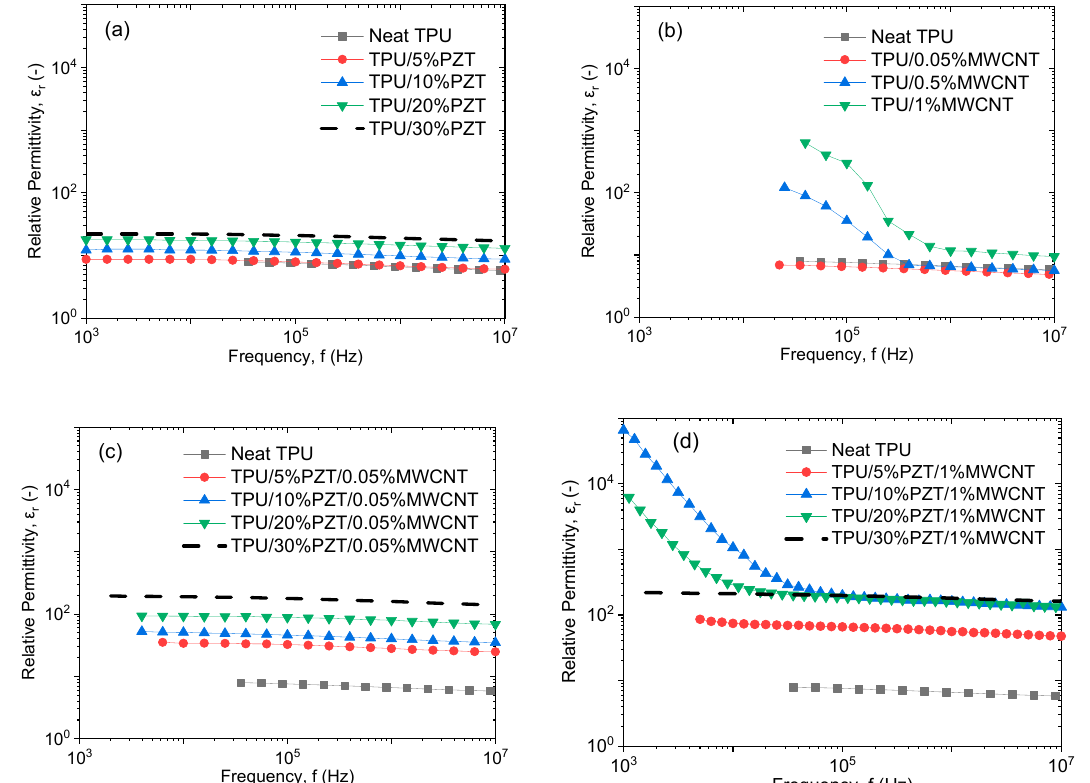
Figure 6. Broadband relative permittivity of ( a ) TPU/PZT, ( b ) TPU/MWCNT, ( c ) TPU/PZT/0.05 vol% MWCNT, and ( d ) TPU/PZT/1 vol% MWCNT.